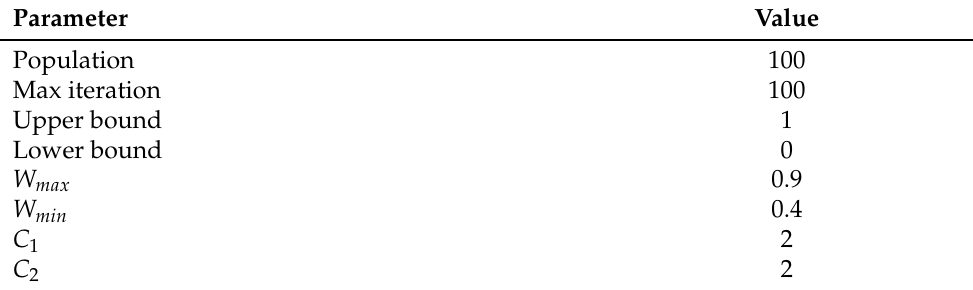
Table 5. PSO parameters.